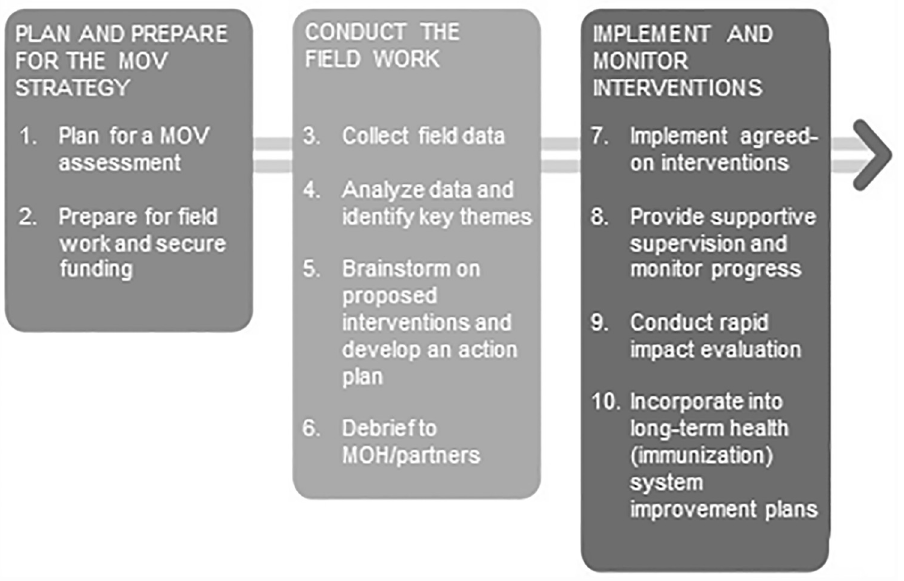
Fig 1. The ten steps of the updated WHO strategy to reduce missed opportunities for vaccination